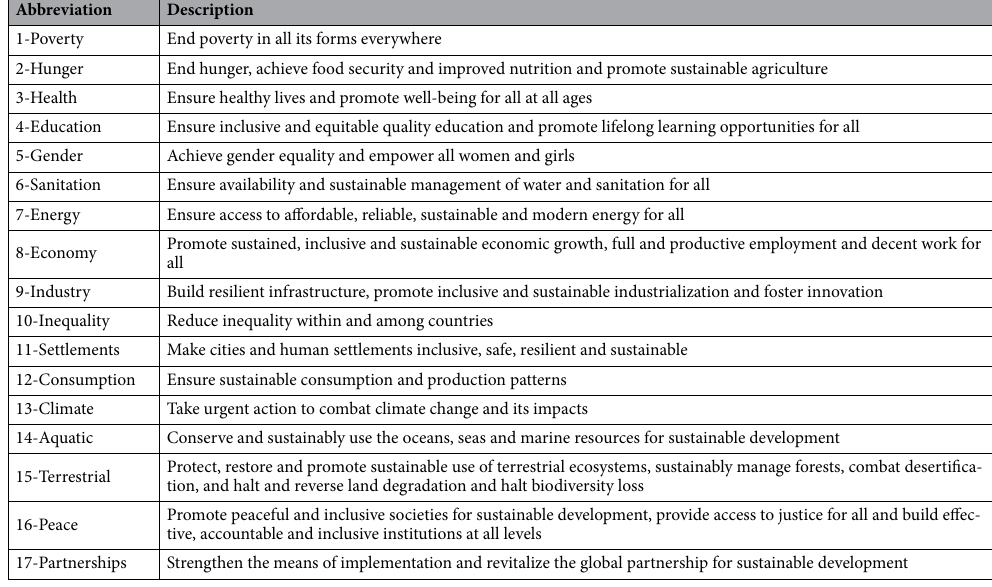
Table 1. Sustainable development goals: abbreviation and full